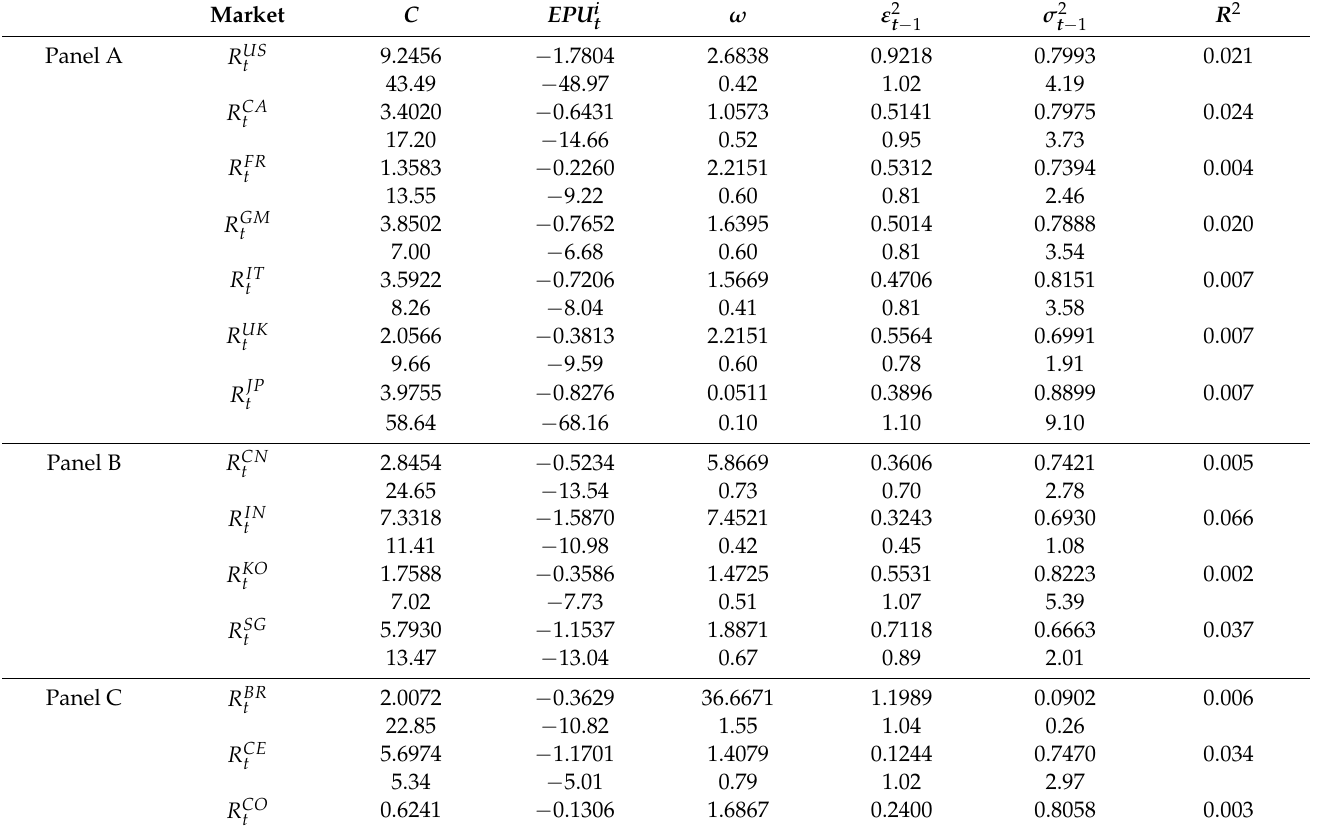
Table 1. Regression estimates of the national stock return on domestic EPU( i ) using the GED– GARCH